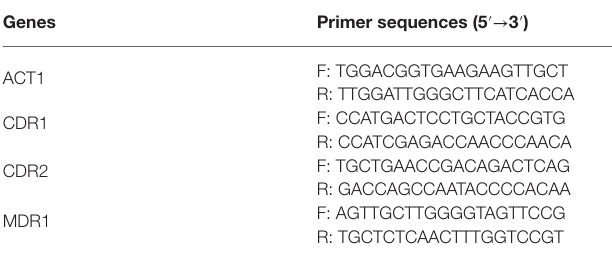
TABLE 1 | Primers used in this study.